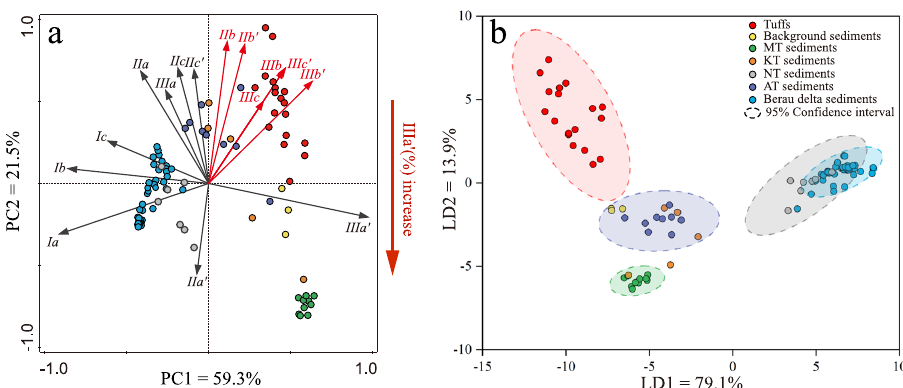
Fig. 5 Multivariate statistical analysis diagram based on relative abundance of 15 brGDGTs. a Principal component analysis; b linear discriminant analysis. Oval shaded areas indicates 95% con fi dence intervals. Tuffs and background sediments from this study, red and yellow, respectively; green, orange, gray, violet circles represent Mariana Trench (MT), Kermadec Trench (KT), New Britain Trench (NT), Atacama Trench (AT) sediments, respectively, and the data from refs. 32,39 ; and indigo circles represent Berau delta sediments, data from ref. 72 .